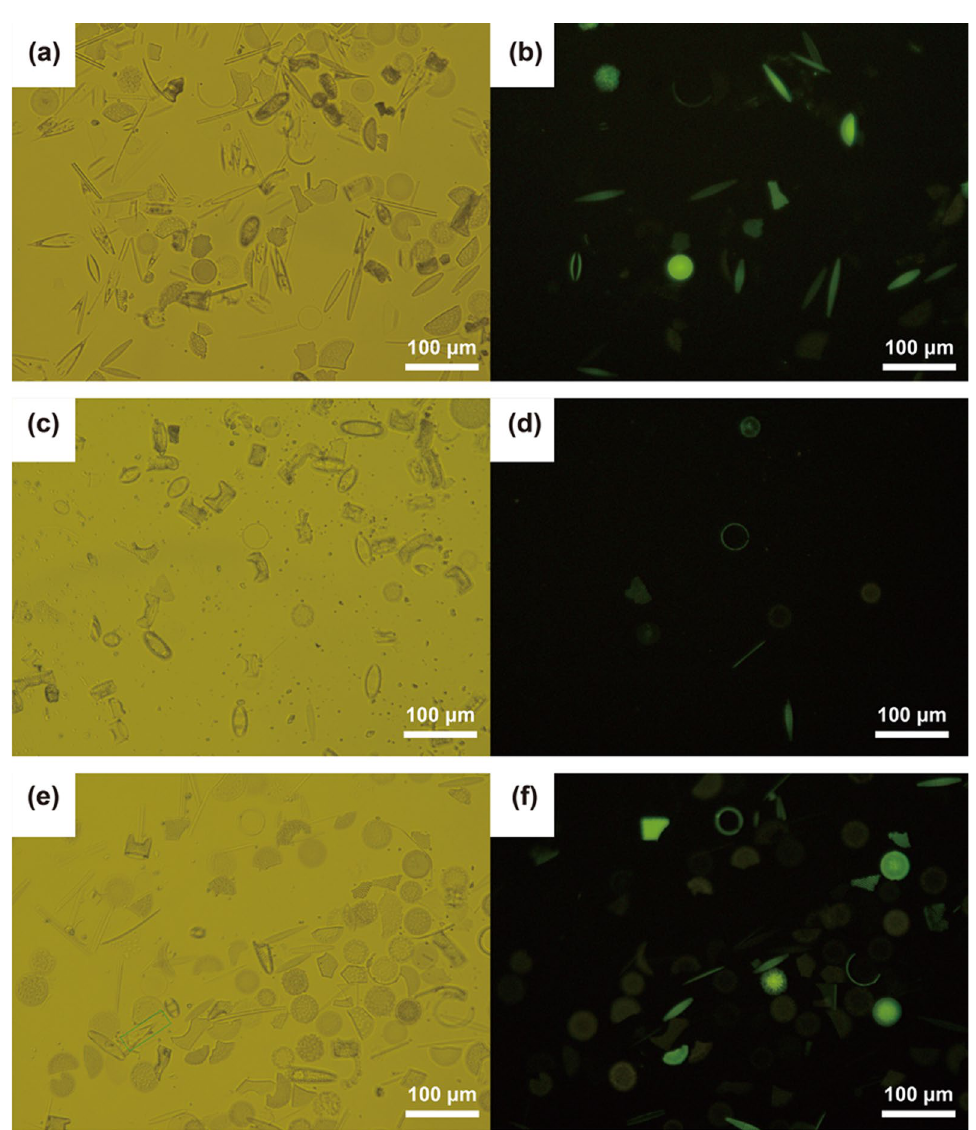
Fig. 3 Photomicrographs of the samples after chemical pretreatment. a, b Sample 382-U1538A-1-2, 24–25 cm. c, d Sample 382-U1538A-3-1, 24–25 cm. e, f Sample 382-U1538A-5-6, 24–25 cm. Images ( a ), ( c ), and ( e) were taken with transmitted light; images ( b ), ( d ), and ( f) were obtained by fluorescence